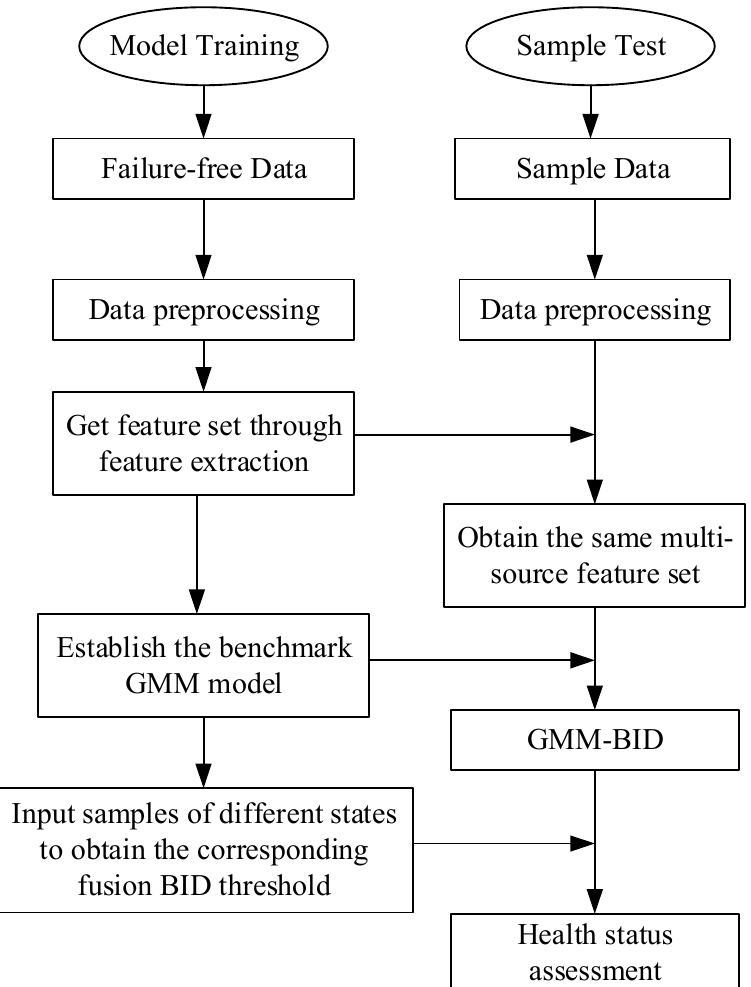
Figure 4. Assessment process based on multi-source information fusion.